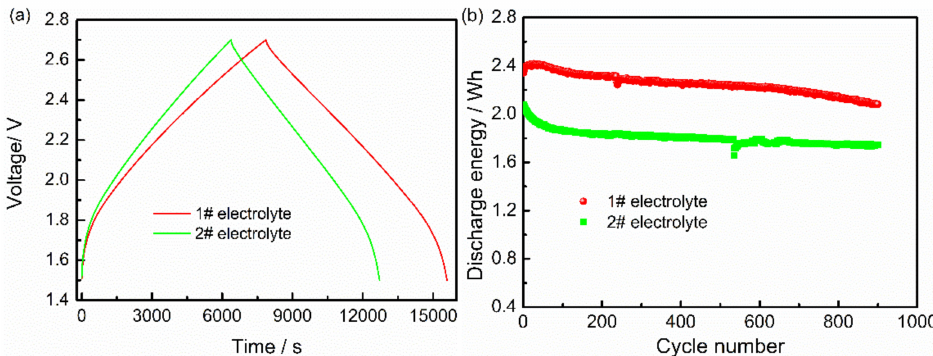
Figure 2. The ( a ) charging/discharging curves and ( b ) cycle life curves of AC/LTO LIC-based different electrolytes.